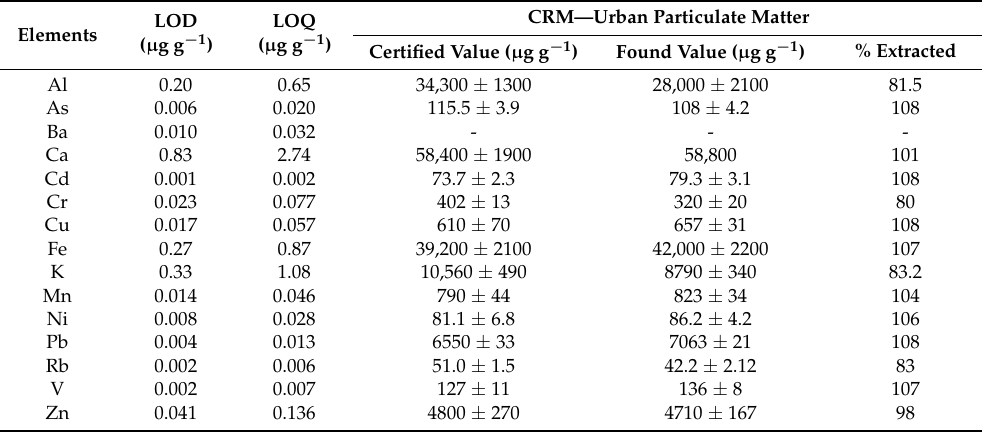
Table 3. Limits of detection (LOD) and limits of quantification (LOQ) by ICP–MS and concentration of Certified Reference Material of urban particulate matter NIST SRM 1648 used to evaluate the extraction